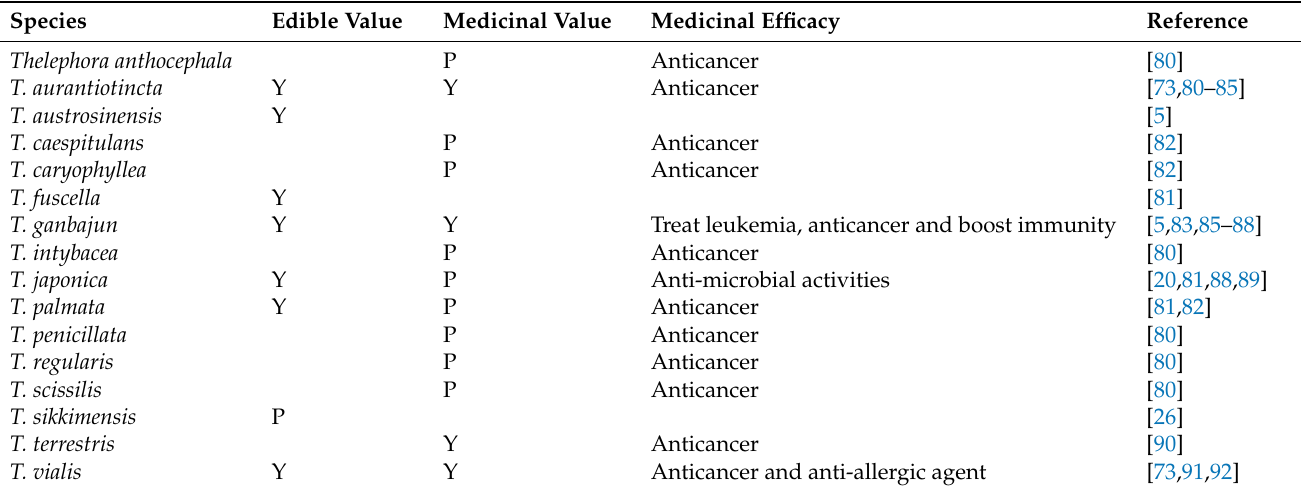
Table 5. Edible and medicinal species of Thelelphora